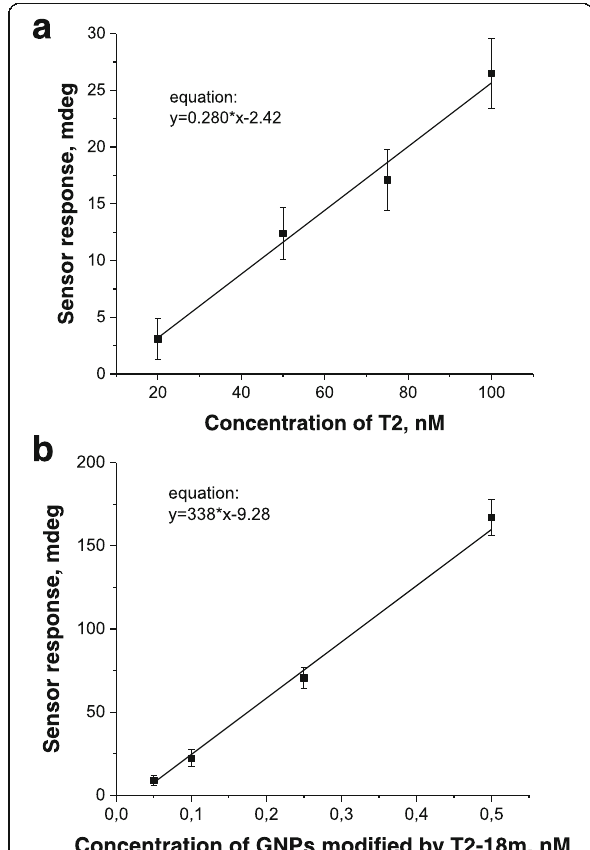
Fig. 4 The linear ranges of the calibration curves of the SPR DNA hybridization sensor response on the injections of the complementary free standing oligonucleotides T2 ( a ) or on the injections of GNPs modified by the complementary oligonucleotides T2-18m ( b